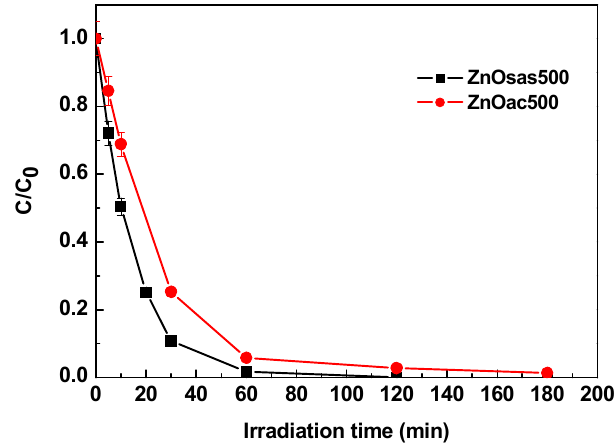
Figure 7. Photocatalytic decolorization of crystal violet (CV) using ZnOac500 and ZnOsas500 under UV irradiation.